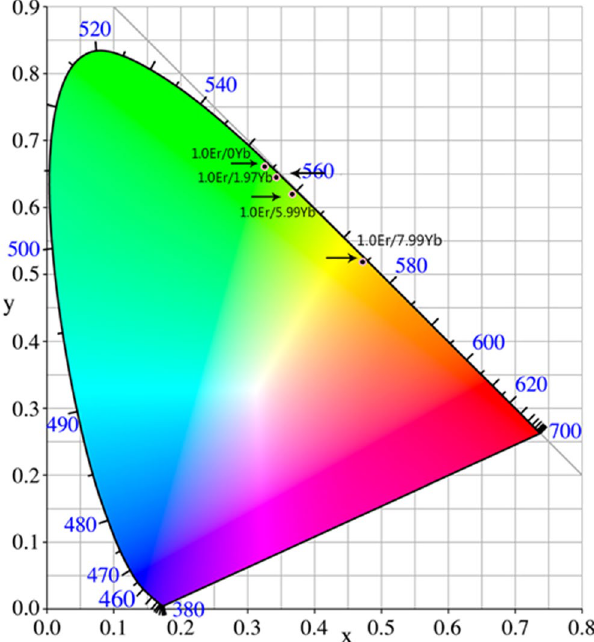
Figure 8. CIE chromaticity coordinates of Er 3 + /Yb 3 + co-doped Na 5 Lu 9 F 32 single